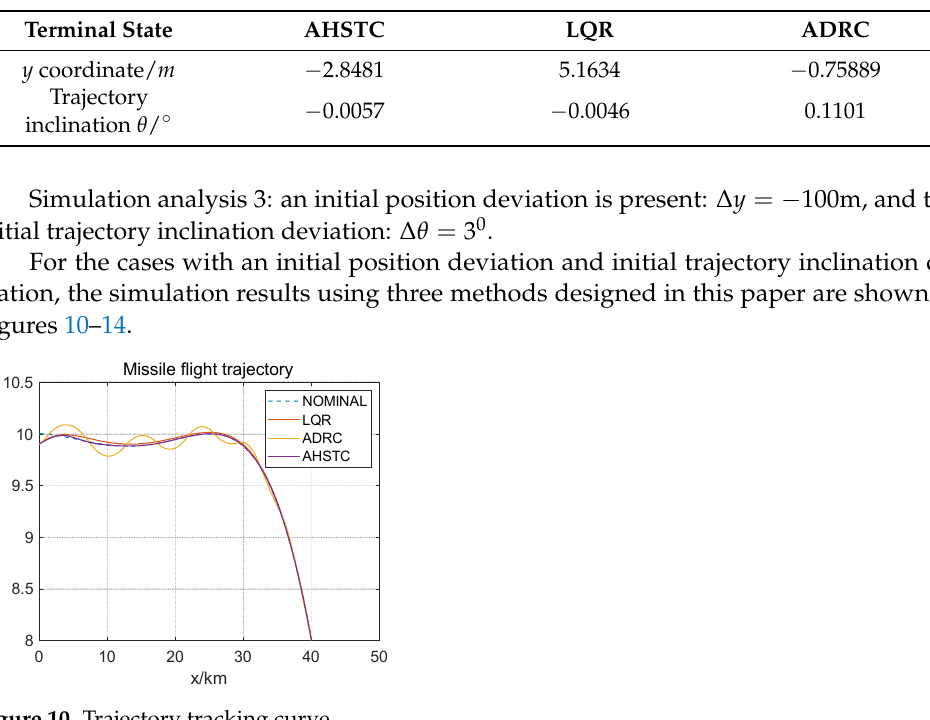
Table 3. Tracking error based on Simulation Analysis 2.